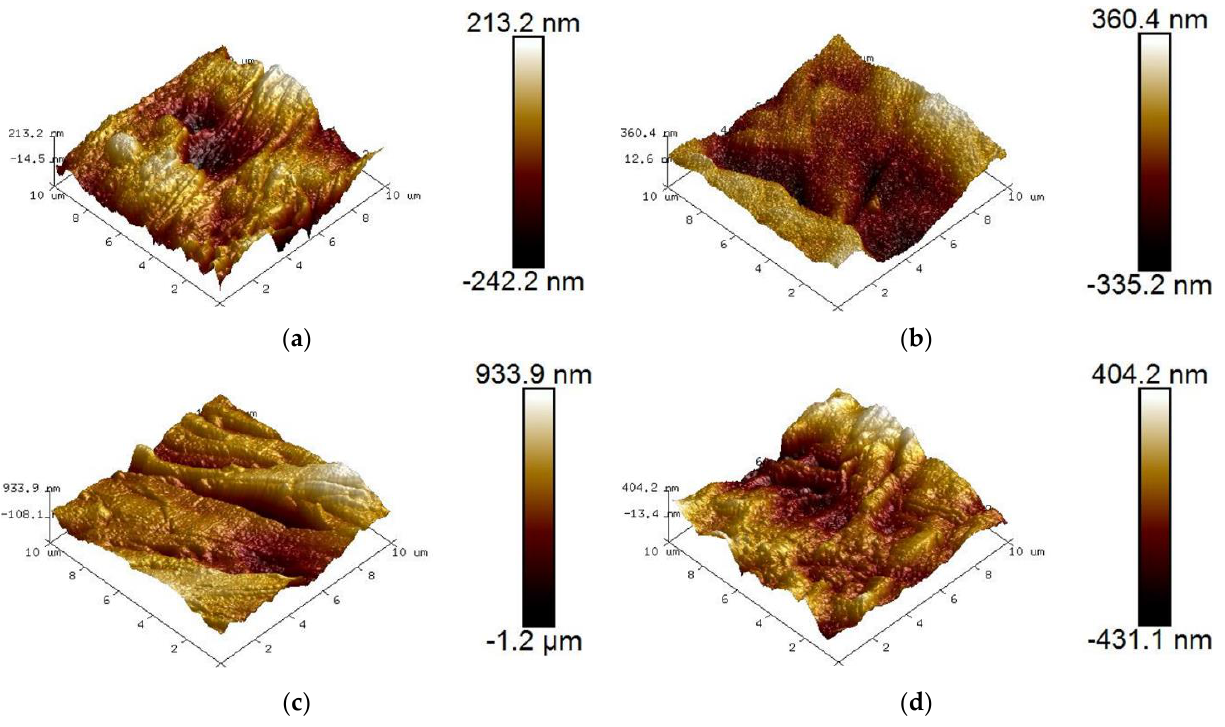
Figure 2. Atomic force microscopy (AFM) test results before and after modification of aramid insulation paper. ( a ) F0 Sample AFM; ( b ) F1 Sample AFM; ( c ) F2 Sample AFM; ( d ) F3 Sample AFM.